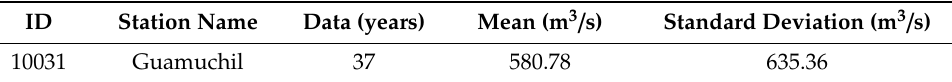
Table 4. Mean and standard deviation of Q for hydrometric station 10031.